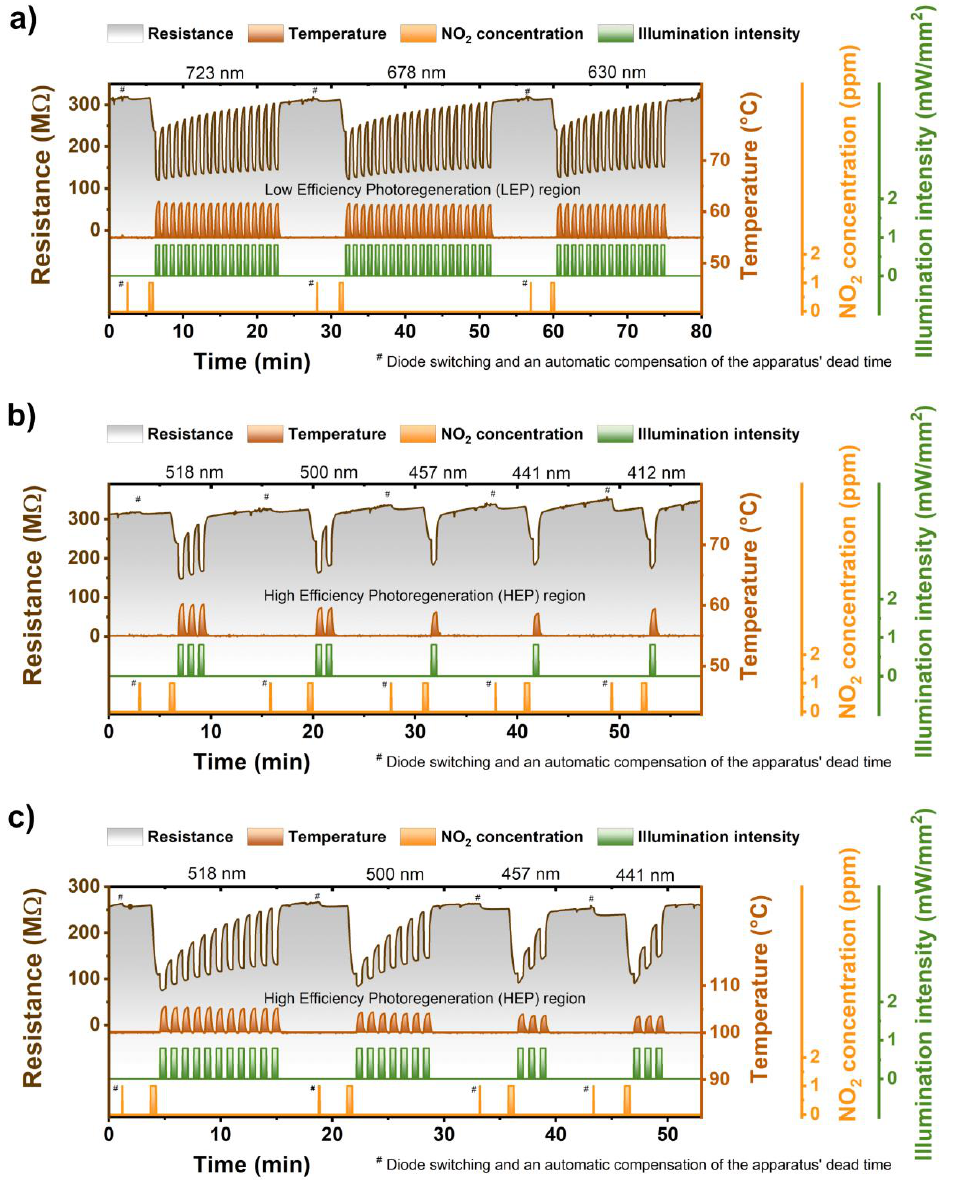
Figure 4. ( a ) Sequence of three ZnPc photoregeneration cycles (30 s sensing period + multiple 30 s illumination pulses) using wavelengths of 723, 678, and 630 nm, illustrating low efficiency of the light with the wavelengths above 550 nm; ( b ) Sequence of five ZnPc photoregeneration cycles carried out by the light of 518, 500, 457, 441, and 412 nm illustrating various photoregeneration efficiencies of the light used; ( c ) the same as ( b ) but at an elevated temperature (100 ◦ C). The hashtag ( # ) marks the region where the diodes were changed and apparatus dead time